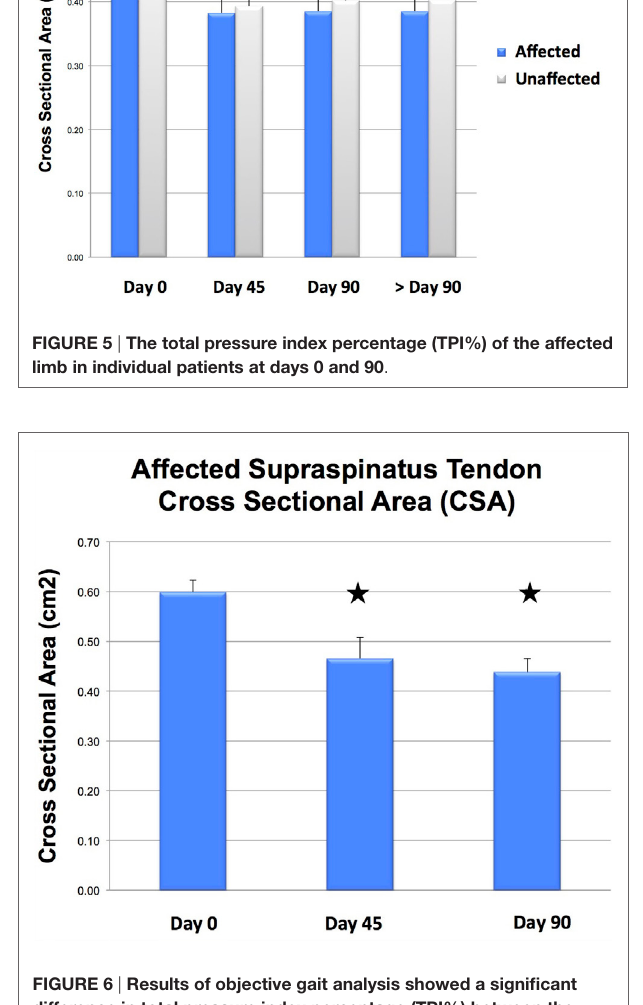
FigUre 6 | results of objective gait analysis showed a significant difference in total pressure index percentage (TPi%) between the injured and contralateral normal forelimb at day 0 ( p = 0.014) . There was no significant difference in total pressure index percentage (TPI%) between the injured and contralateral normal forelimb at day